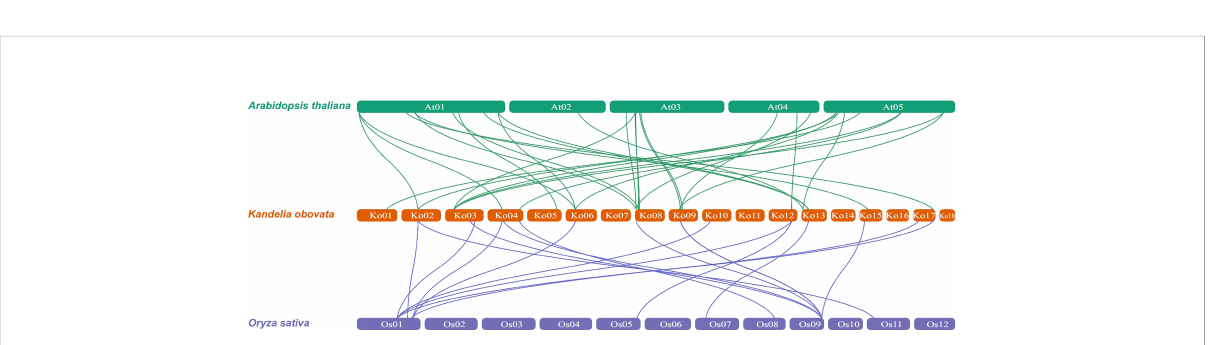
FIGURE 5 Synteny analysis of NAC genes between Kandelia obovata and two representative plant species ( Arabidopsis thaliana and Oryza sativa ). Green and blue lines represent syntenic NAC gene pairs of K. obovata and A. thaliana and O. sativa , respectively.